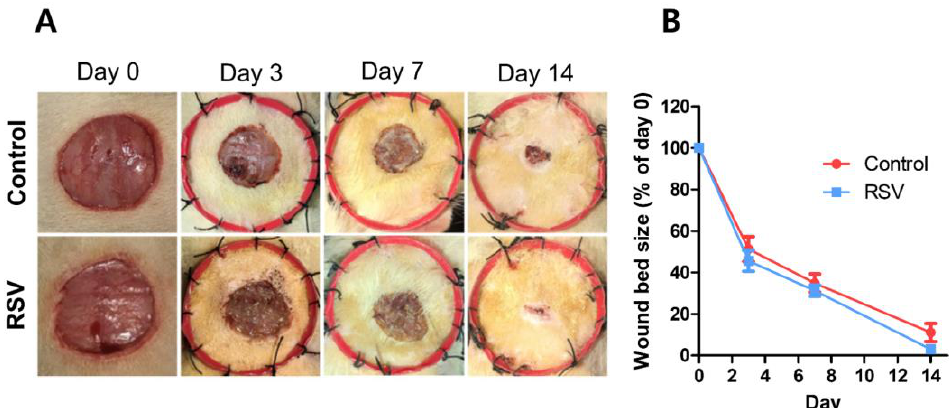
Figure 6. Effect of resveratrol on wound healing. ( A ): Representative images of wound bed size from two groups. ( B ): Quantitation of wound bed sizes. Reproduced with permission from Zhou et al., “Resveratrol accelerates wound healing by attenuating oxidative stress-induced impairment of cell proliferation and migration”, published by Elsevier, 2021